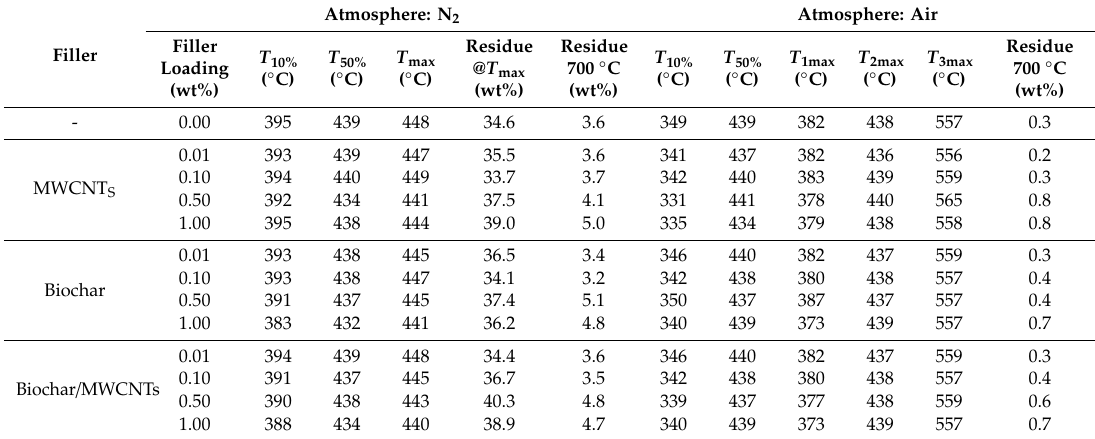
Table 1. Thermal and thermo-oxidative stability of the UV-LED EB150 film and its composites *.